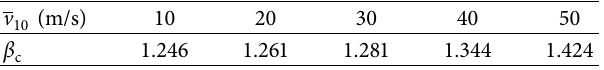
Figure 6: Influence of mean wind speed ( v Table 3: Influence of wind speed on the dynamic wind load factor of the windage yaw angle.